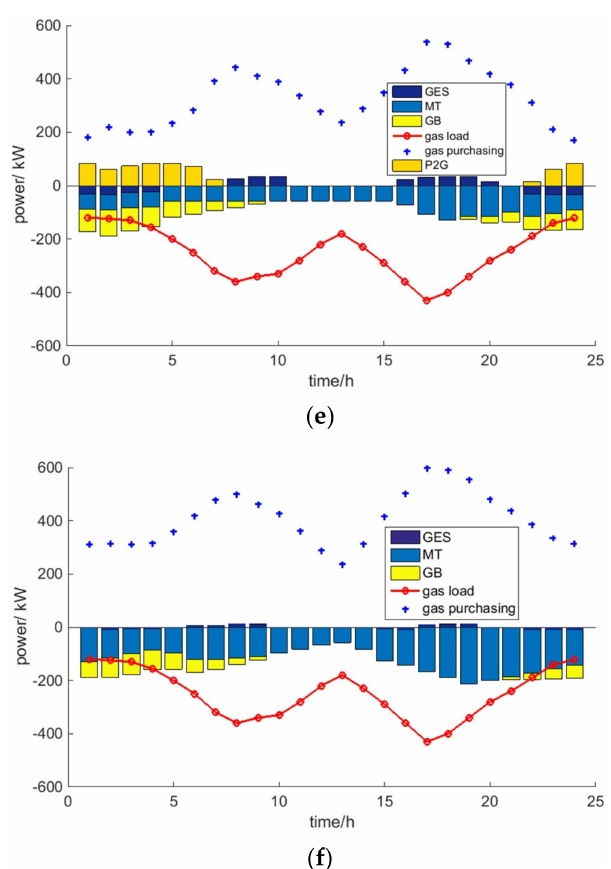
Figure 4. ( a ) Electrical output of equipment in o ff -grid mode; ( b ) Electrical output of equipment in grid-connected mode; ( c ) Heat output of equipment in o ff -grid mode; ( d ) Heat output of equipment in grid-connected mode;( e ) Gas output of equipment in o ff -grid mode; ( f ) Gas output of equipment